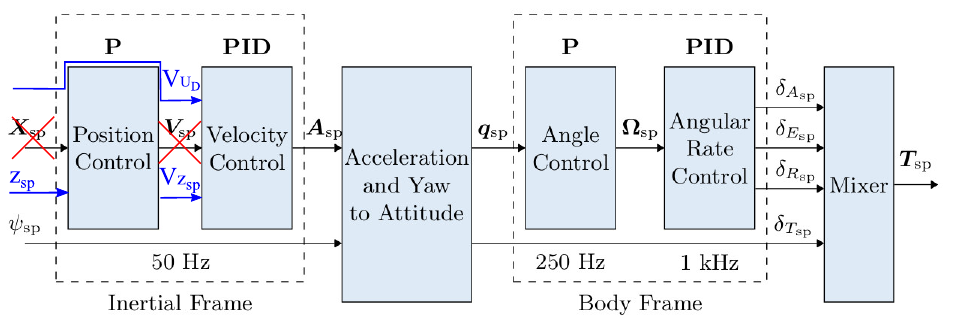
Figure 12. Modified autopilot control architecture